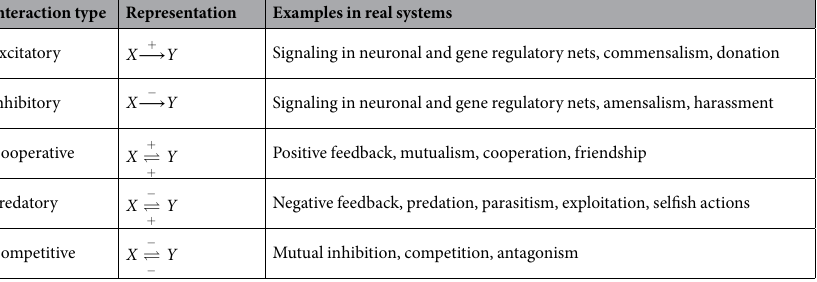
Table 1. Types of interactions with those representation by links, and examples in real